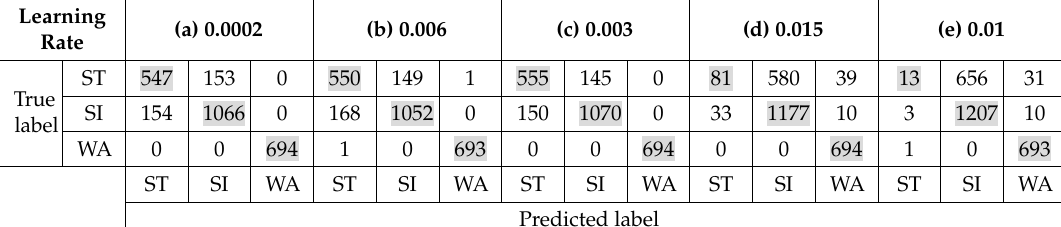
Table 6. Confusion matrices: (OR only)—200-feature vector dataset.